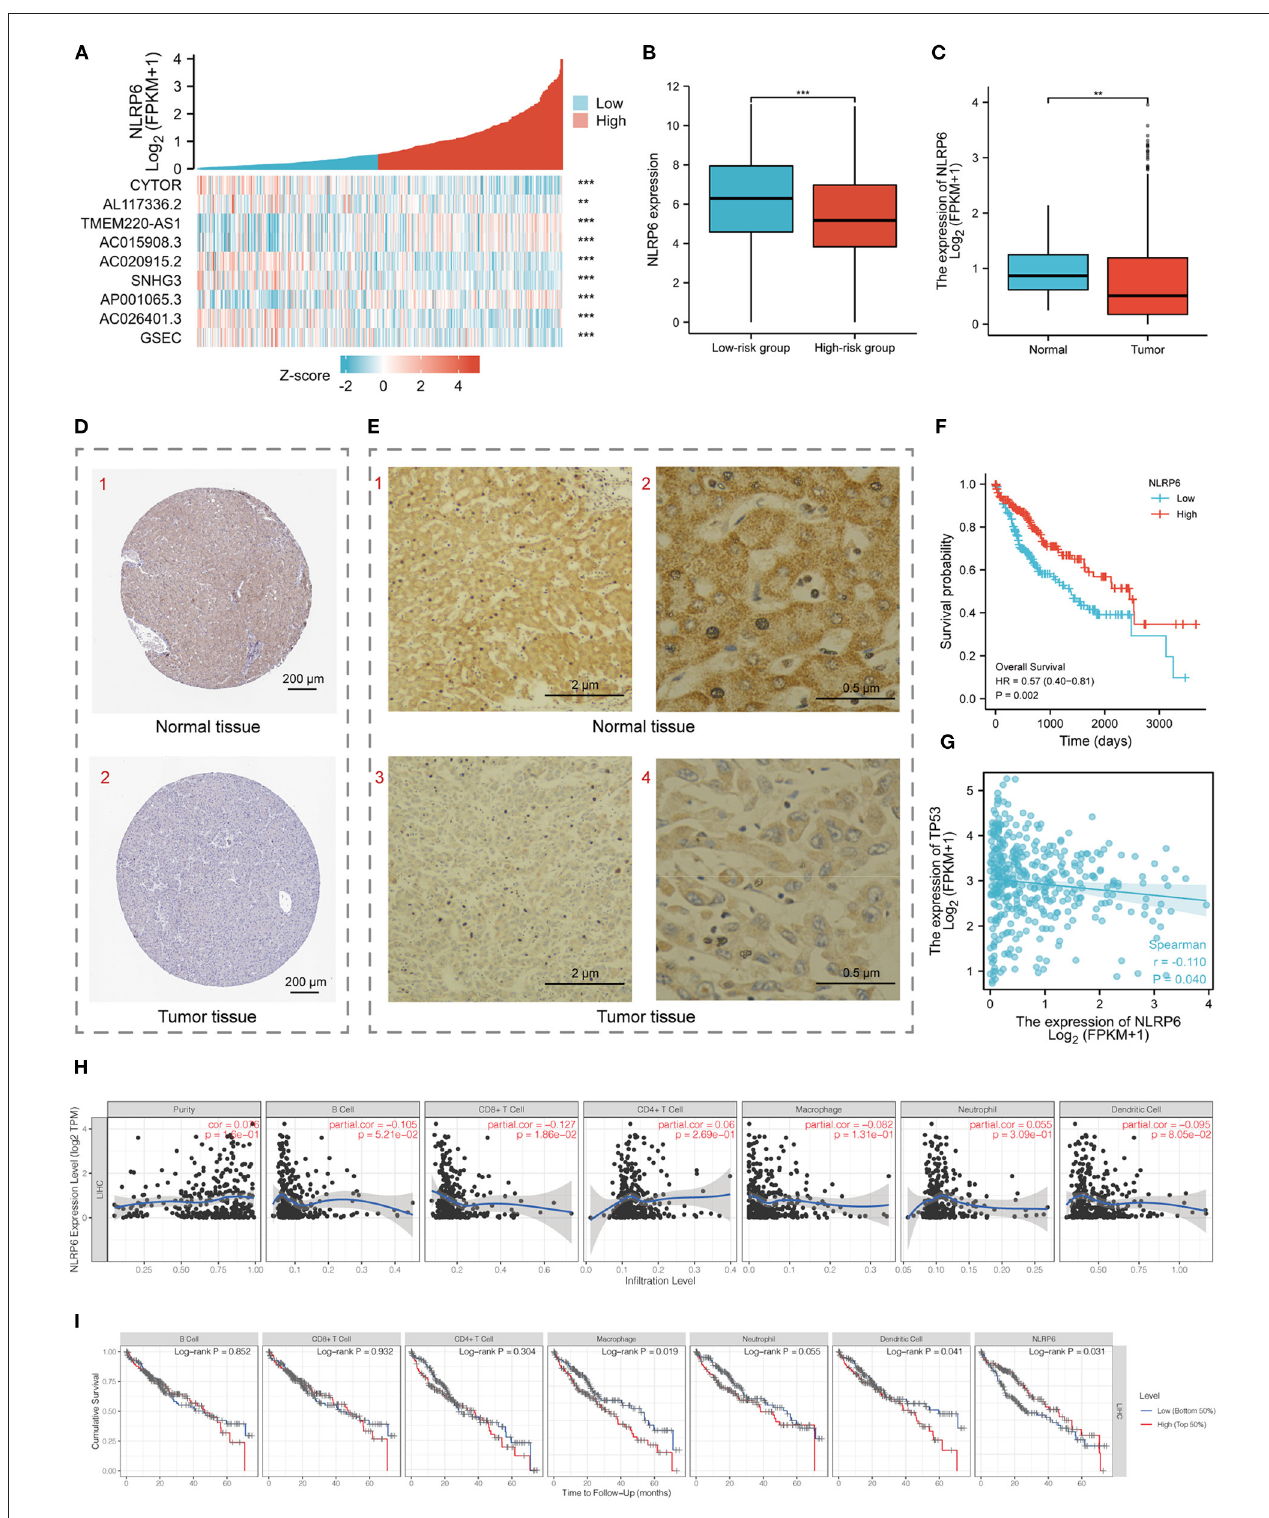
FIGURE 6 | (A) Heatmap for the co-expression of 9 pyroptosis-related prognostic lncRNAs with NLRP6. (B) Histogram for NLRP6 mRNA different expression between low-and high-risk groups. (C) Histogram for NLRP6 different expression between normal and tumor tissues based on LIHC-TCGA database. (D) Validation of the expression of NLRP6 on the translational level by the Human Protein Atlas database (immunohistochemistry, IHC), scale bar = 200 µ m. (E) Representative IHC